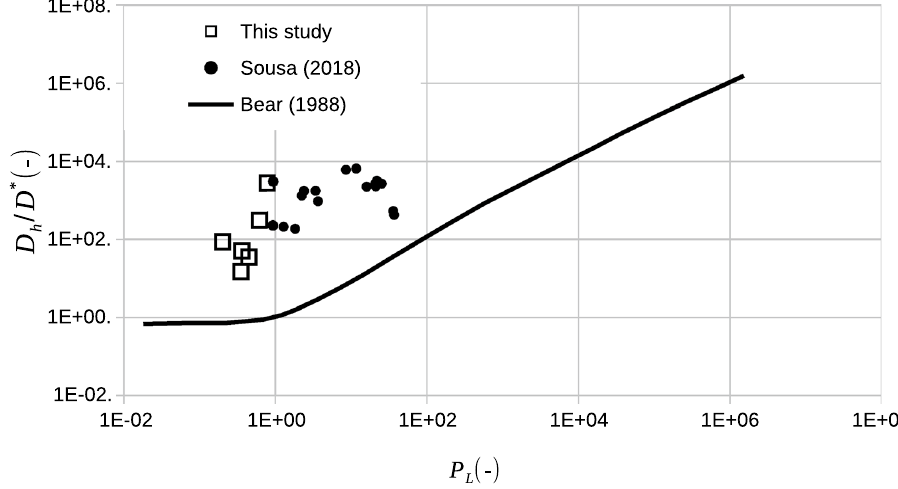
Figure 6. Hydrodynamic dispersion behaviour of column tests performed with PPW compared with values presented in the literature.